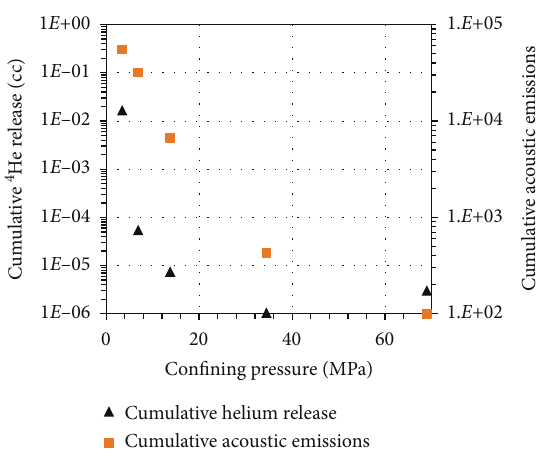
Figure 4: Cumulative helium release and acoustic emissions versus con fi ning